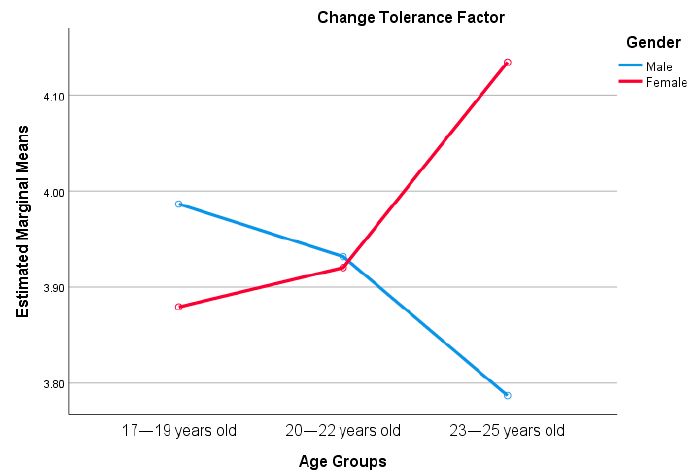
Figure 2. Interaction effect between gender and age, and tolerance to change.